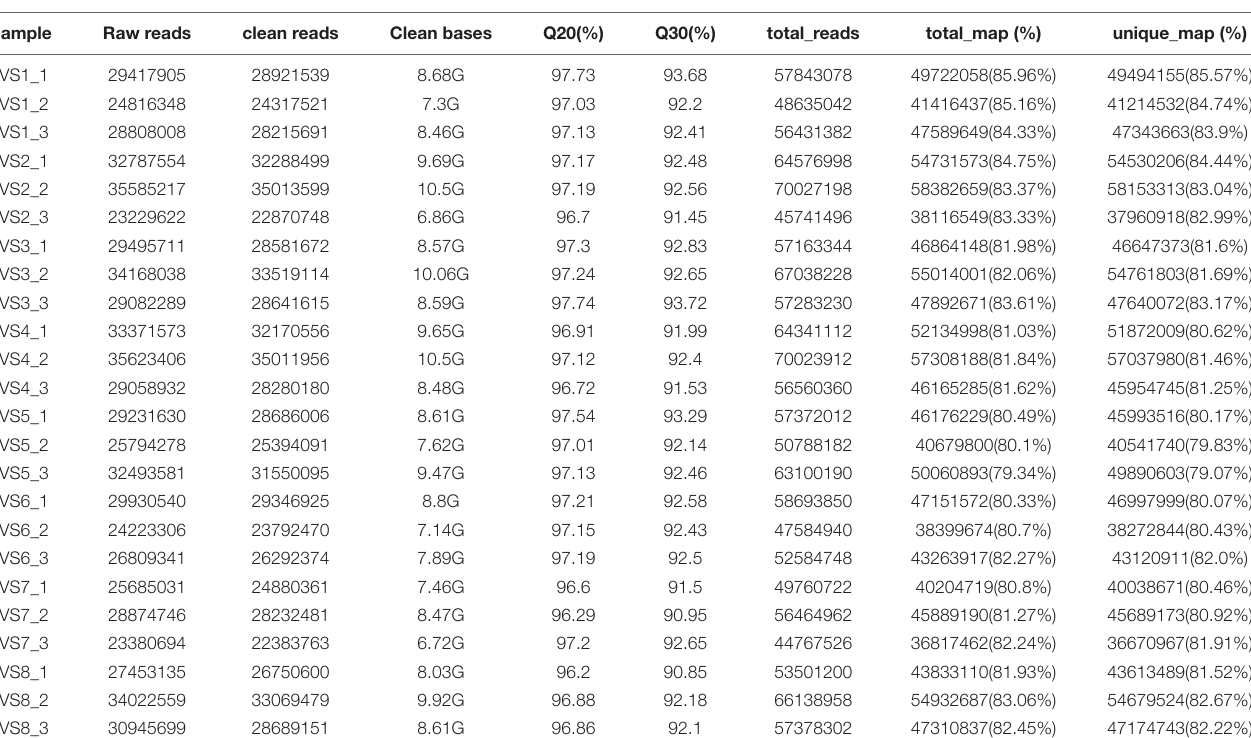
TABLE 1 | Statistical analysis of sequencing